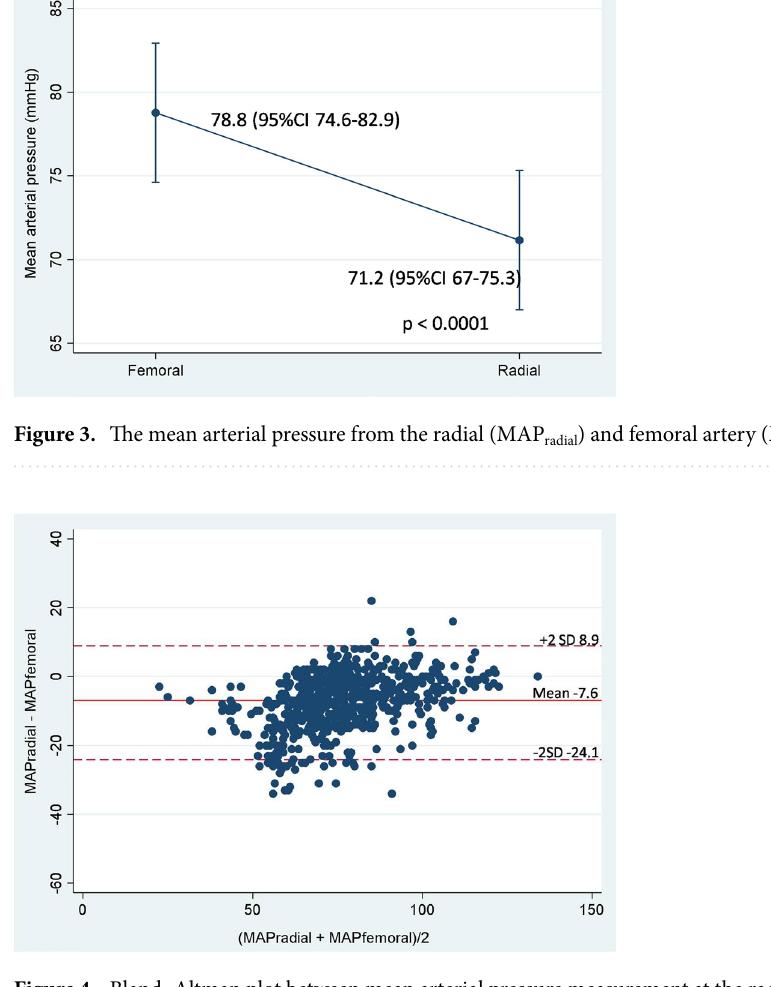
Figure 4. Bland–Altman plot between mean arterial pressure measurement at the radial (MAP radial ) and femoral artery (MAP femoral ).